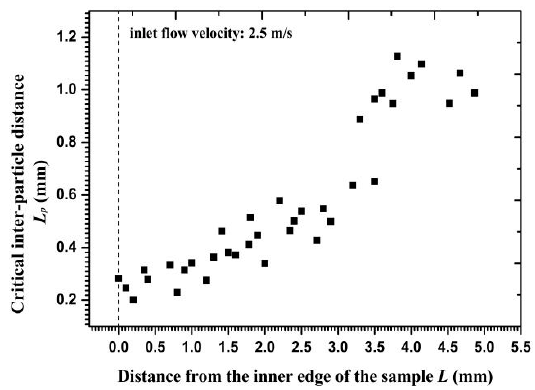
Figure 13. Critical inter-particle distance versus the distance from the inner edge.